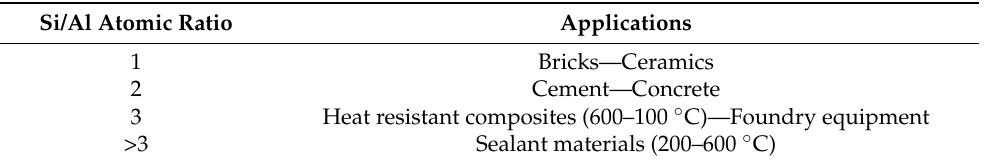
Table 2. Some applications of geopolymeric materials based on Si:Al ratio